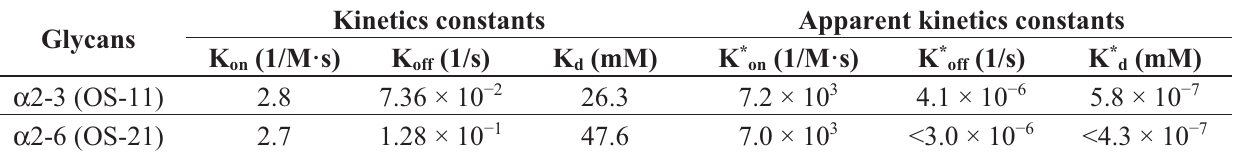
Table 2. Equilibrium rate constants of monovalent sialyllactoses (OS-11 and OS-21) binding to hemagglutinin (HA) on immobilized influenza virus A/Mem71 (H3N1) and apparent equilibrium rate constants of multivalent binding of HA on influenza virus A/Mem71 to immobilized sialyllactoses at T = 298K.